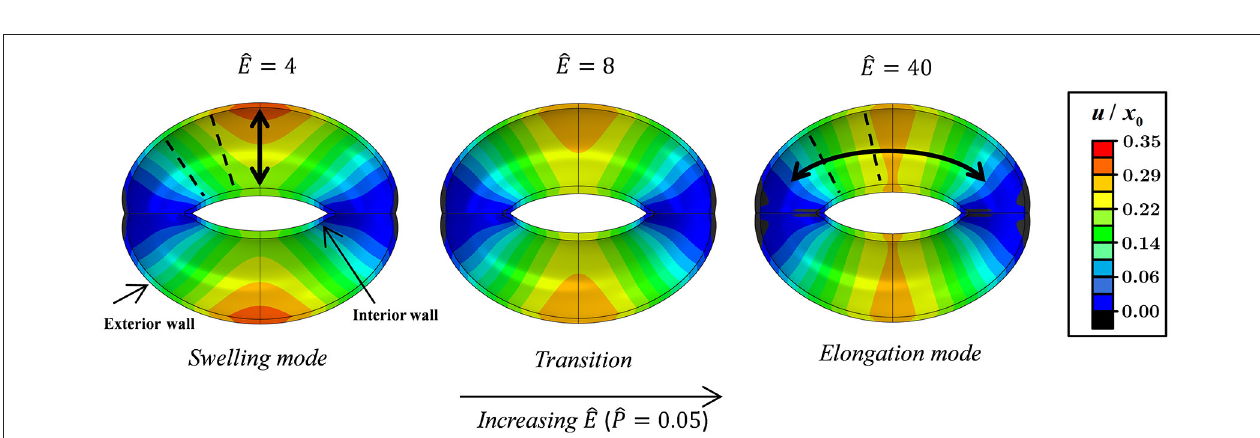
FIGURE 4 | Displacement maps of stomatal opening normalized according to x 0 for increasing ˆ E -values with ˆ P elongation modes (see also Supplementary Video S2). Interior and exterior walls are indicated by arrows. Selected guard cell cross sections are illustrated by dashed